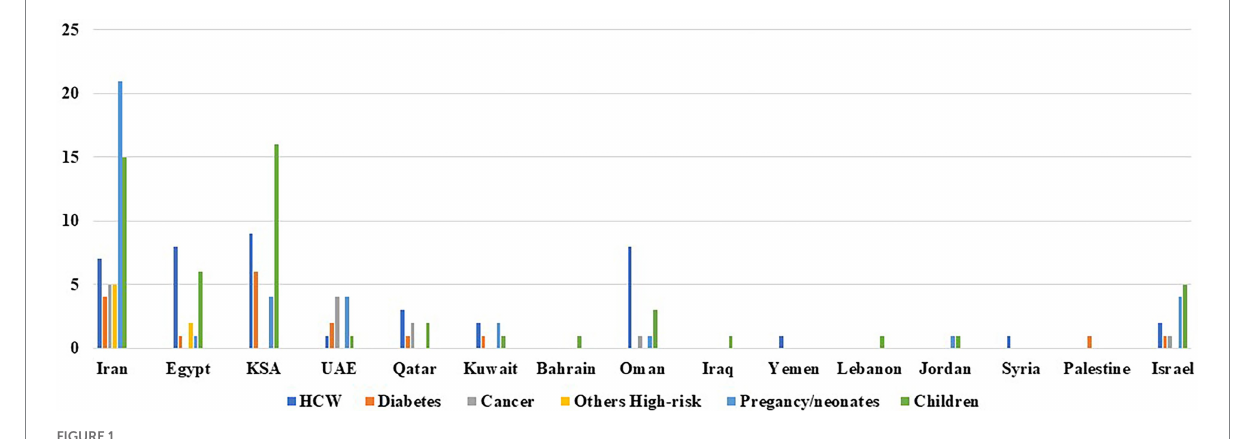
FIGURE 1 Number of published papers in each category per country in the Middle